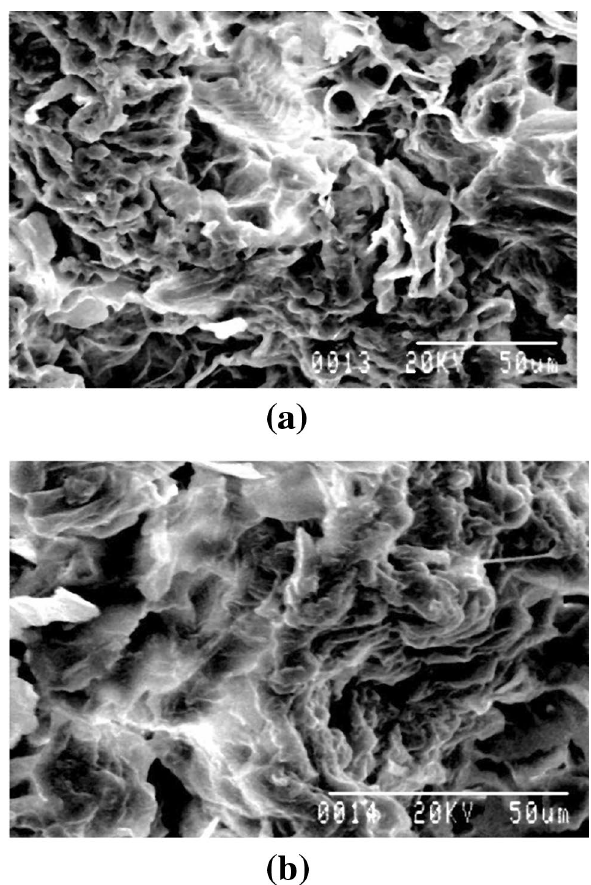
Fig. 2 Scanning electron microscopy of banana peel: a before passing fluoride solution (×1500 magnification), b after passing fluoride solu- tion (×1500 magnification)